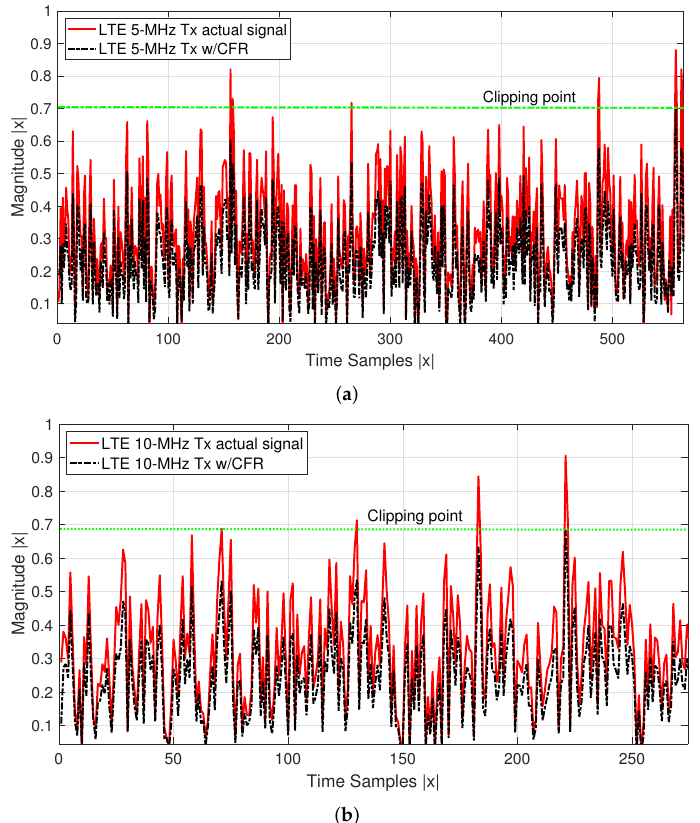
Figure 3. ( a ) LTE–5 and ( b ) 10–MHz actual signal vs. CFR signal for time samples.